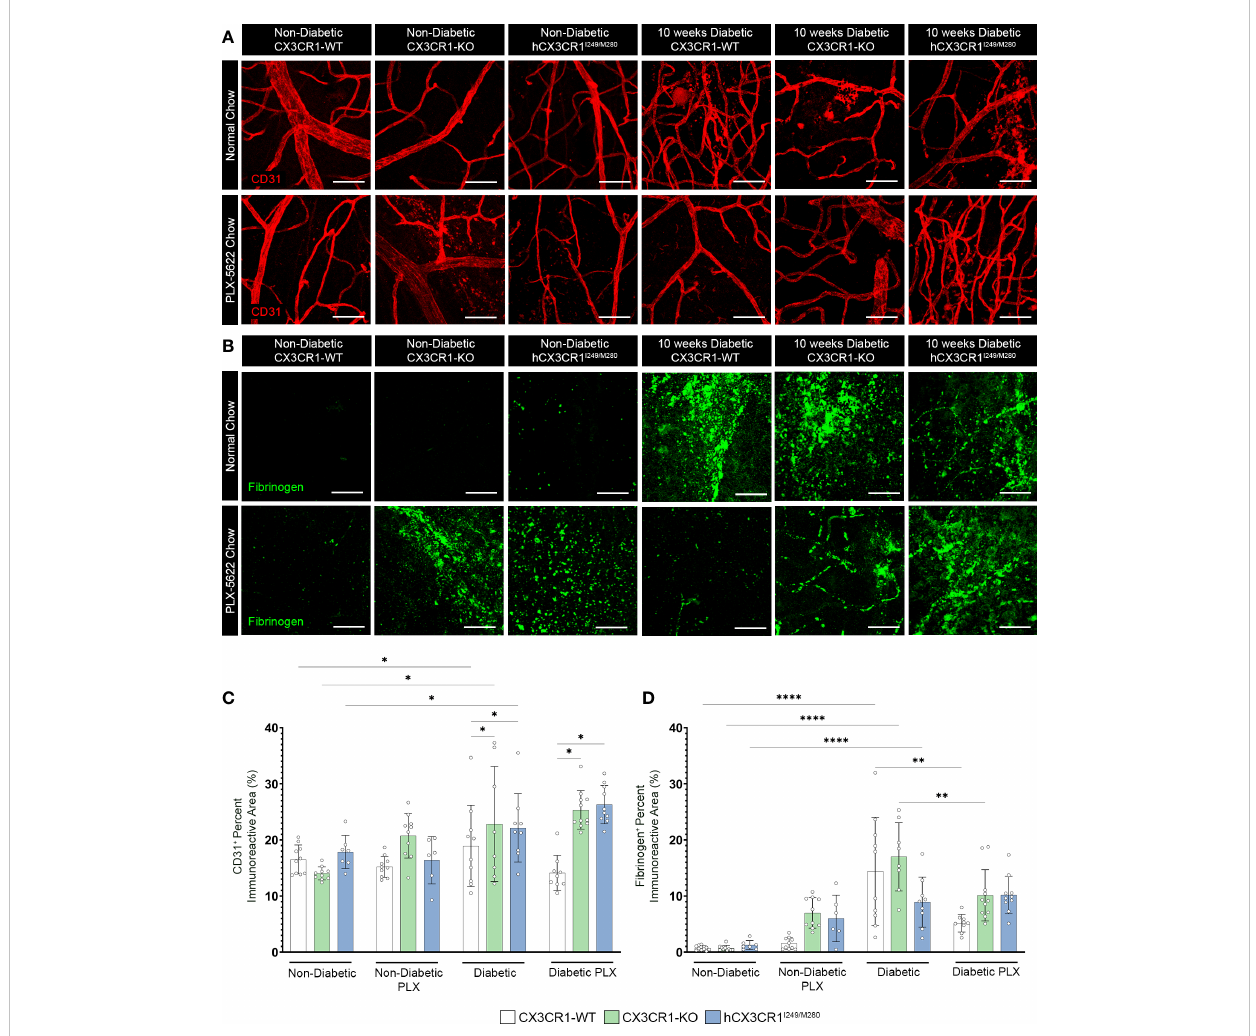
FIGURE 5 PLX-5622 treatment does not alleviate angiogenesis in the diabetic CX3CR1 -KO and hCX3CR1 I249/M280 retina. Microglia were pharmacologically depleted using PLX-5622 in non-diabetic and 8-wks diabetic CX3CR1 -WT, CX3CR1 -KO, and hCX3CR1 I249/M280 mice for two weeks. Non-diabetic control mice received citrate buffer. Non-depleted, non-diabetic and diabetic controls remained on normal chow. Confocal images of retinal tissues stained for CD31 (red) (A) and fi brinogen (green) (B) in CX3CR1 -WT, CX3CR1 -KO and hCX3CR1 I249/M280 mice. Confocal images represent the retinal ganglion cell layer in the peripheral retina. (C, D) , Quanti fi cation of retinal IHC analysis for CD31 + percent immunoreactive area (C) and fi brinogen + percent immunoreactive area (D) . Data show the average of the 2 central, 2 medial and 2 peripheral images taken per mouse. Data show mean ± SD, n = 6 to 10 mice per group where each dot represents an individual mouse. * P <0.05, ** P <0.01, **** P <0.0001 using 2-way ANOVA. Scale bars measure